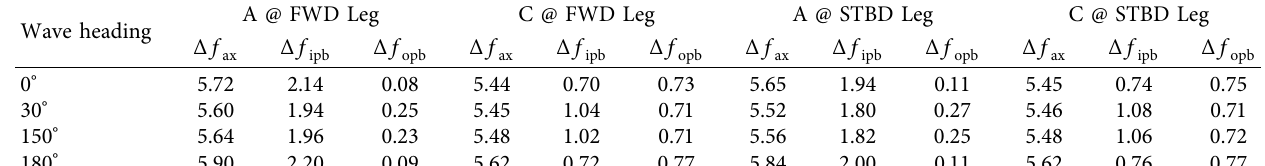
Absolute value of stress is smaller than 0.5